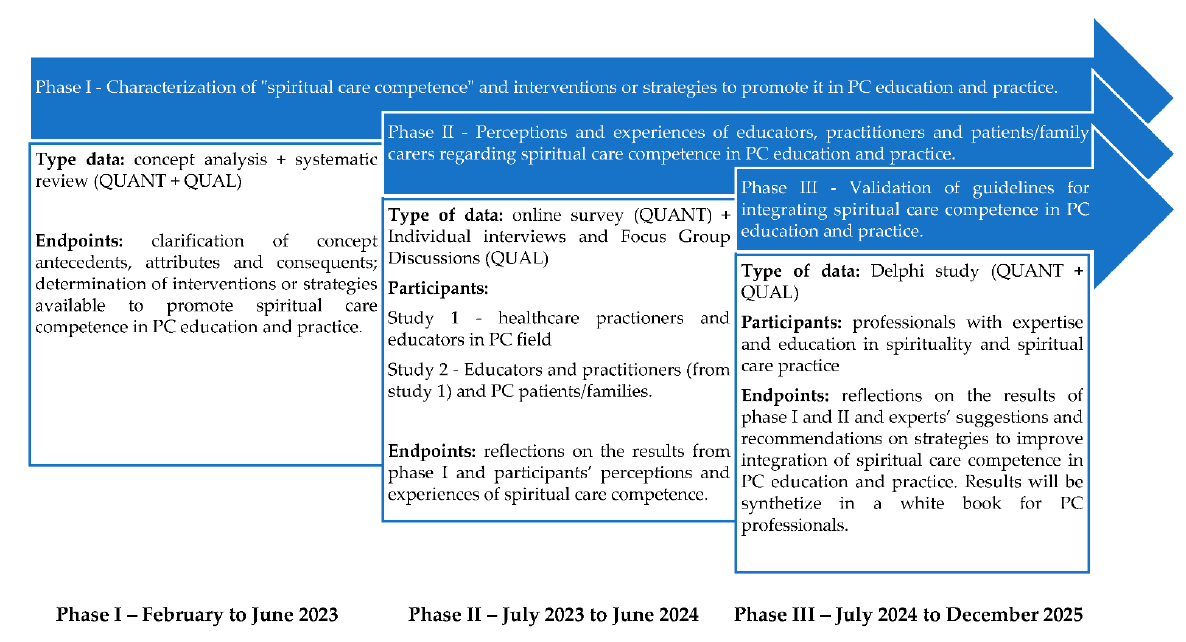
Figure 1. Study overview.